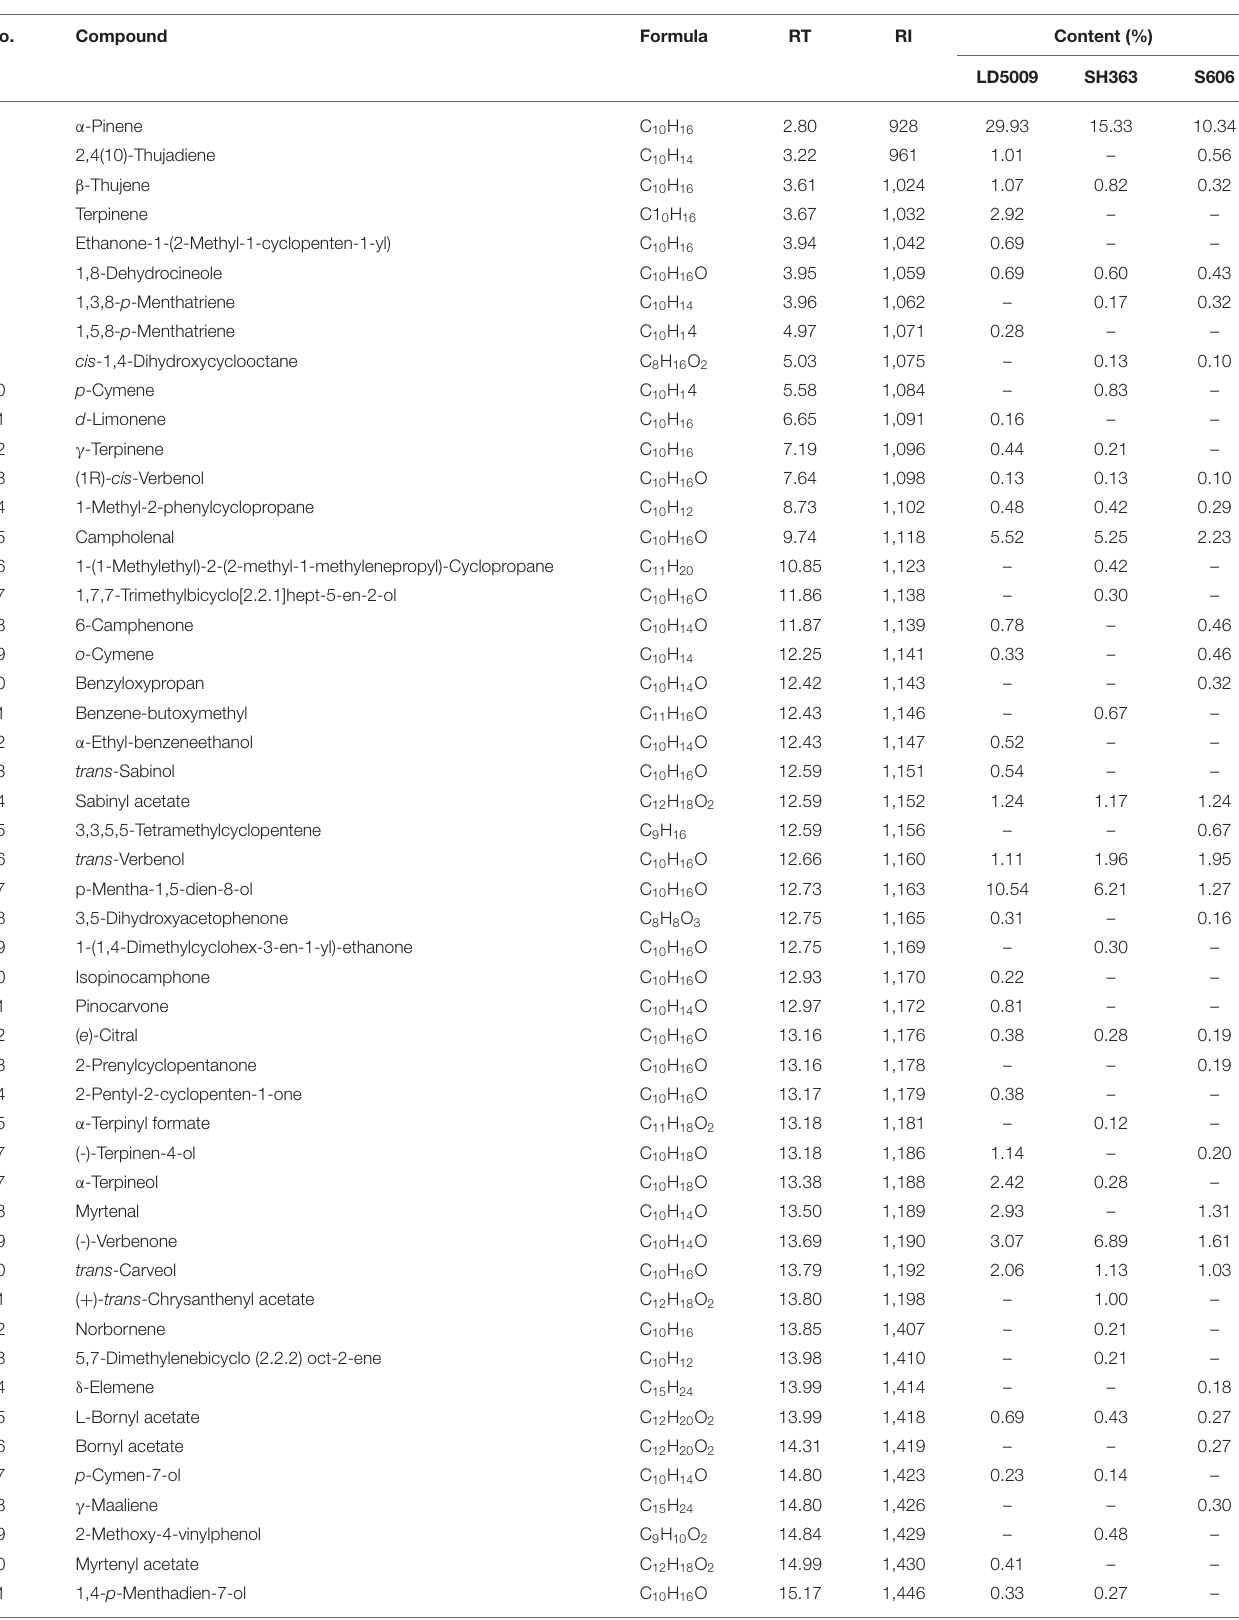
TABLE 5 | Chemical compounds of SEOs from different varieties of sunflowers. No.